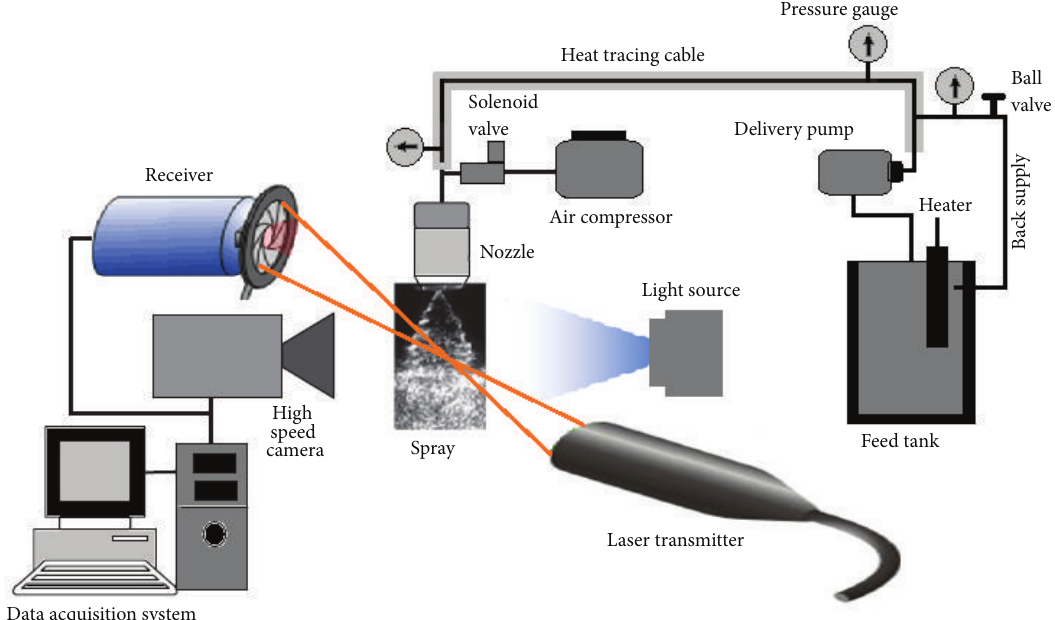
Figure 1: Schematic of the experimental setup used for generation and characterization of water spray.